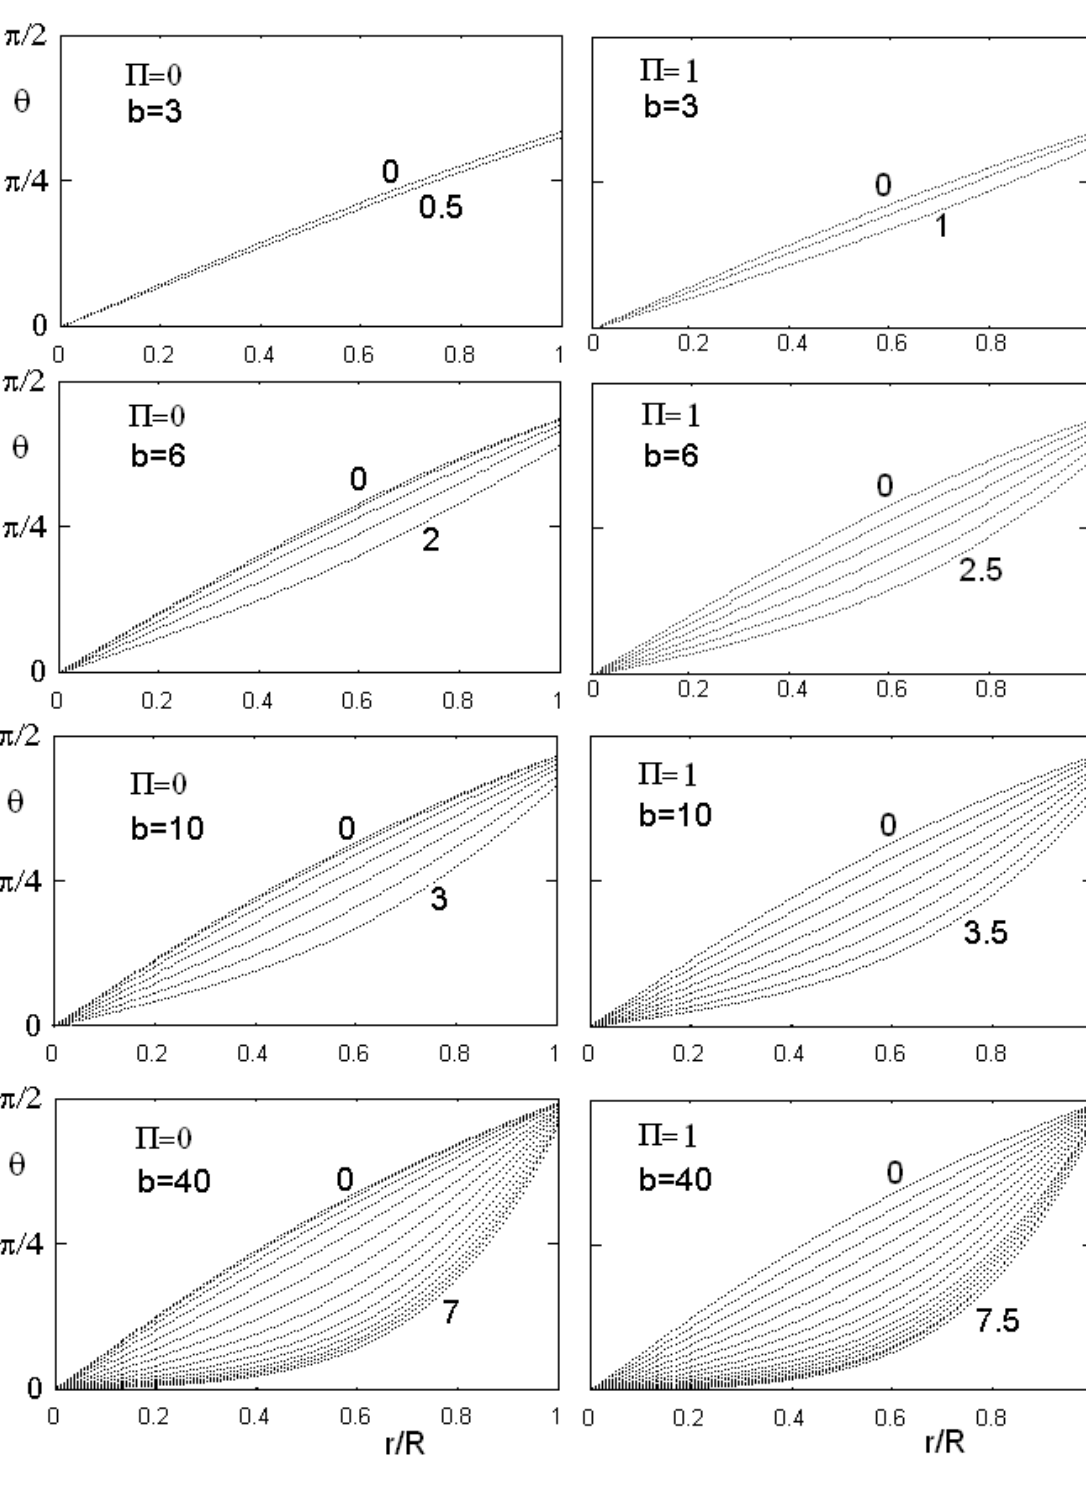
Figure 8. Behaviour of θ as a function of the reduced radial coordinate Rr in the case of flexoelectric coefficient Π equal to 0 and 1, for different values of the anchoring parameter b and dimensionless electric field (some values are reported on the curves). As the electric field is higher that a threshold value, angle θ goes to zero, that is the director field is parallel to the cylinder